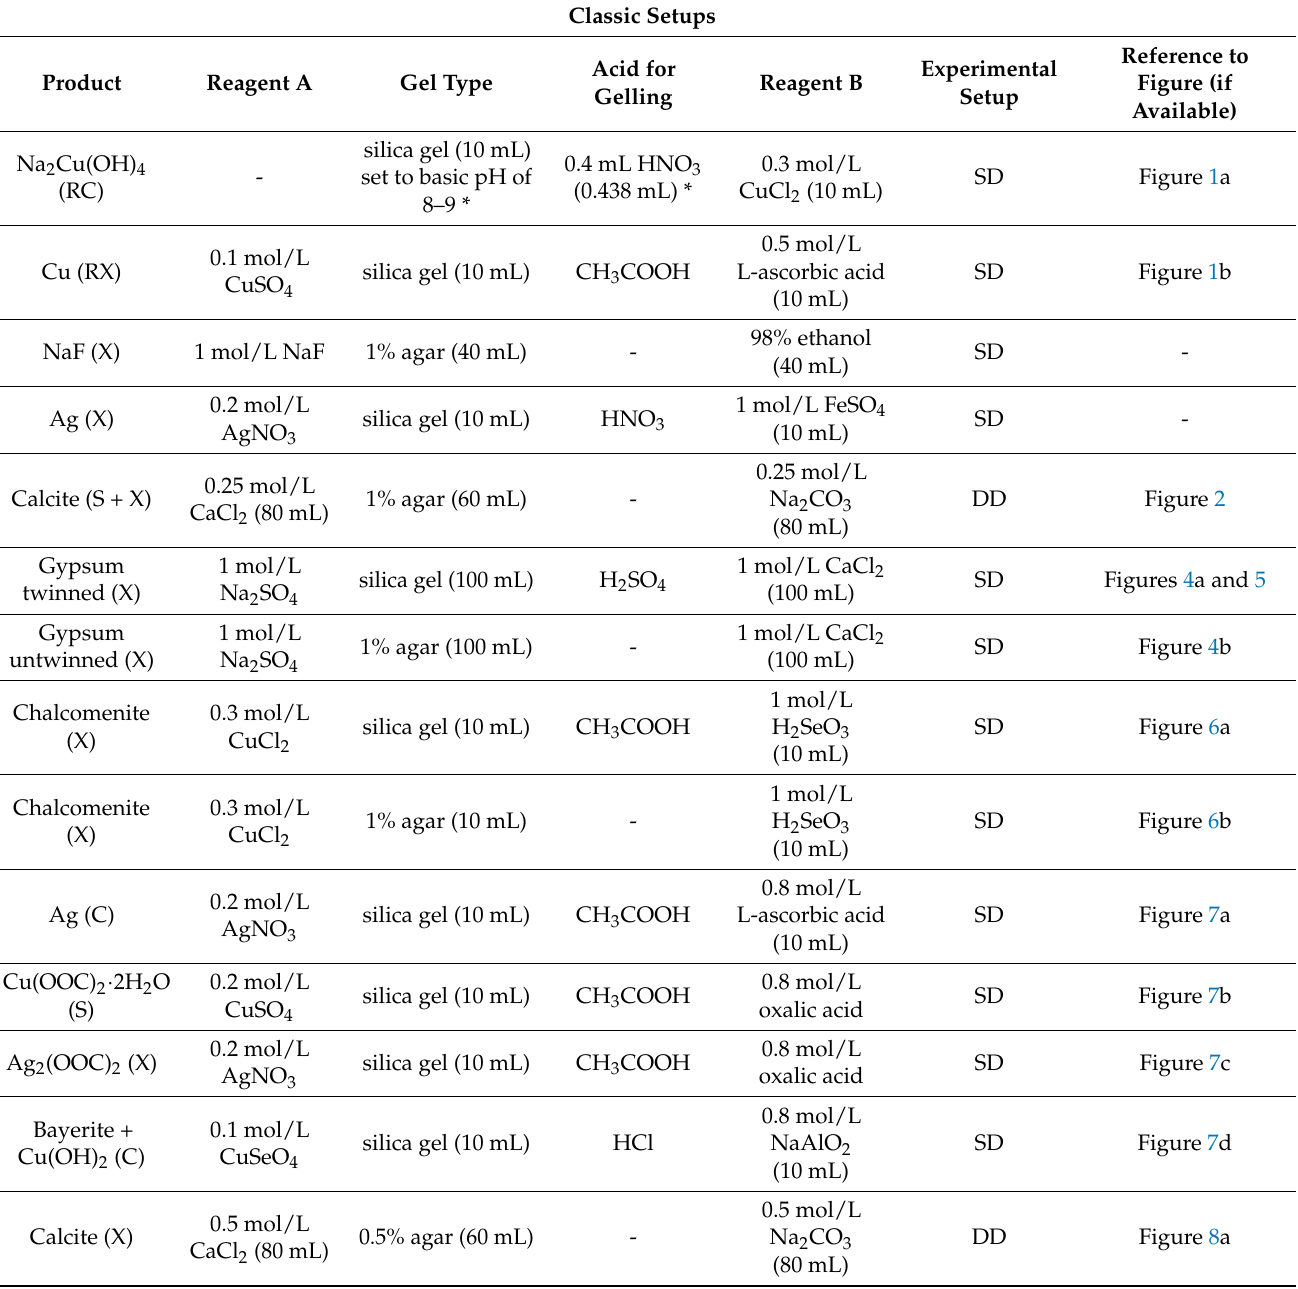
Table A1. Summary of the reagents used, the obtained product, its character and configuration of all experiments conducted by our group. For the specific experiment configuration, the following abbreviations are used: SD —single-diffusion (Figure 3a); DD —double diffusion (Figure 3b); HSDI